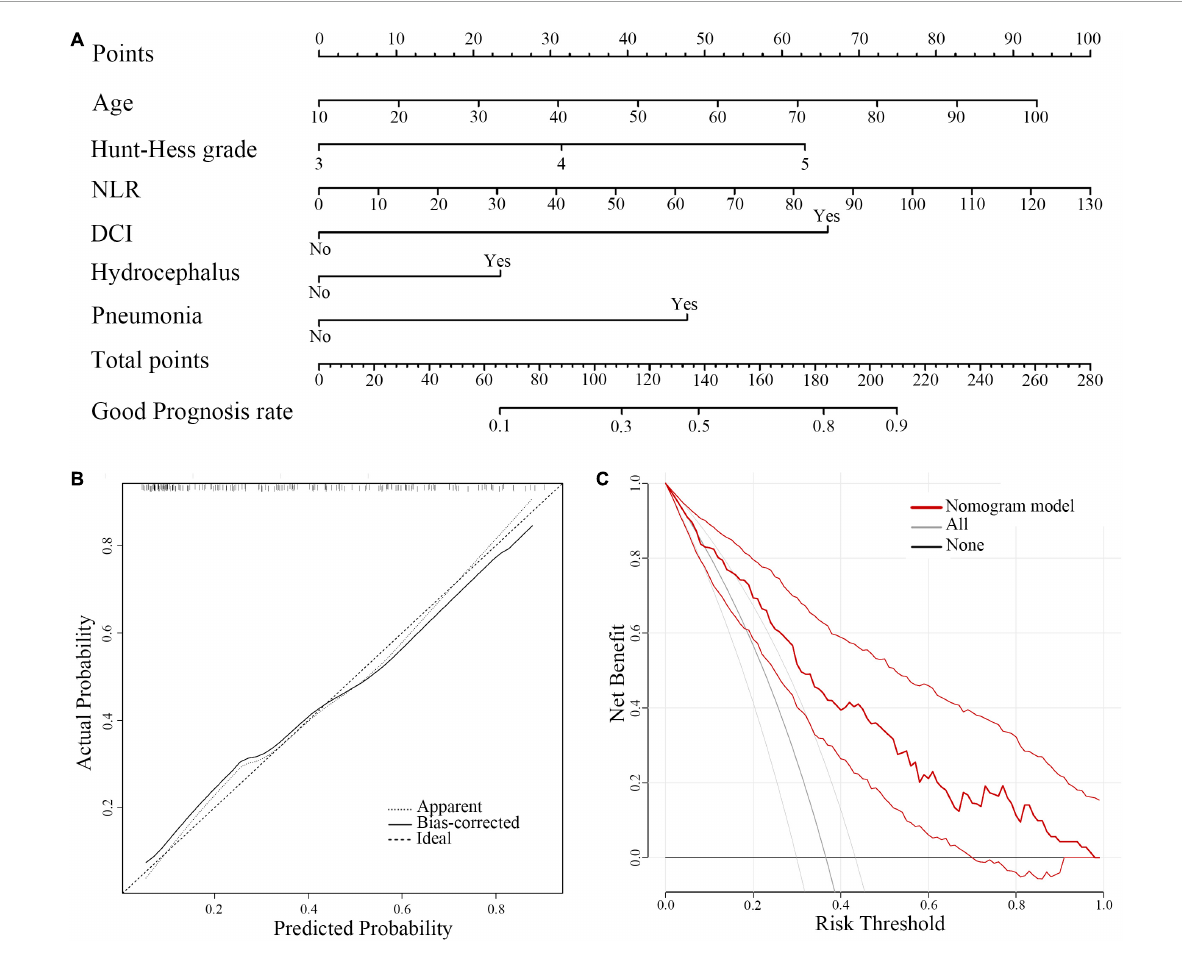
FIGURE3 A Nomogram model for predicting 6-month favorable outcomes in severe SAH patients (HH III-IV). (A) A predictive nomogram model. (B) The calibration curves for the nomogram. (C) The DCA of the training cohort. NLR, neutrophil-to-lymphocyte ratio; DCI, delayed cerebral ischemia; DCA, decision curve